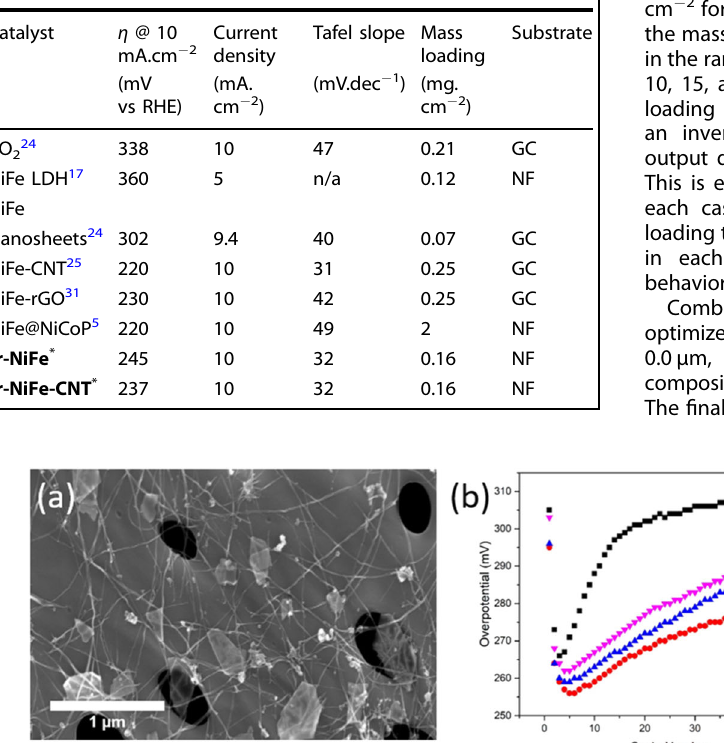
Table 1. Comparative OER activities for various competitive NiFe LDH catalyst systems (* this